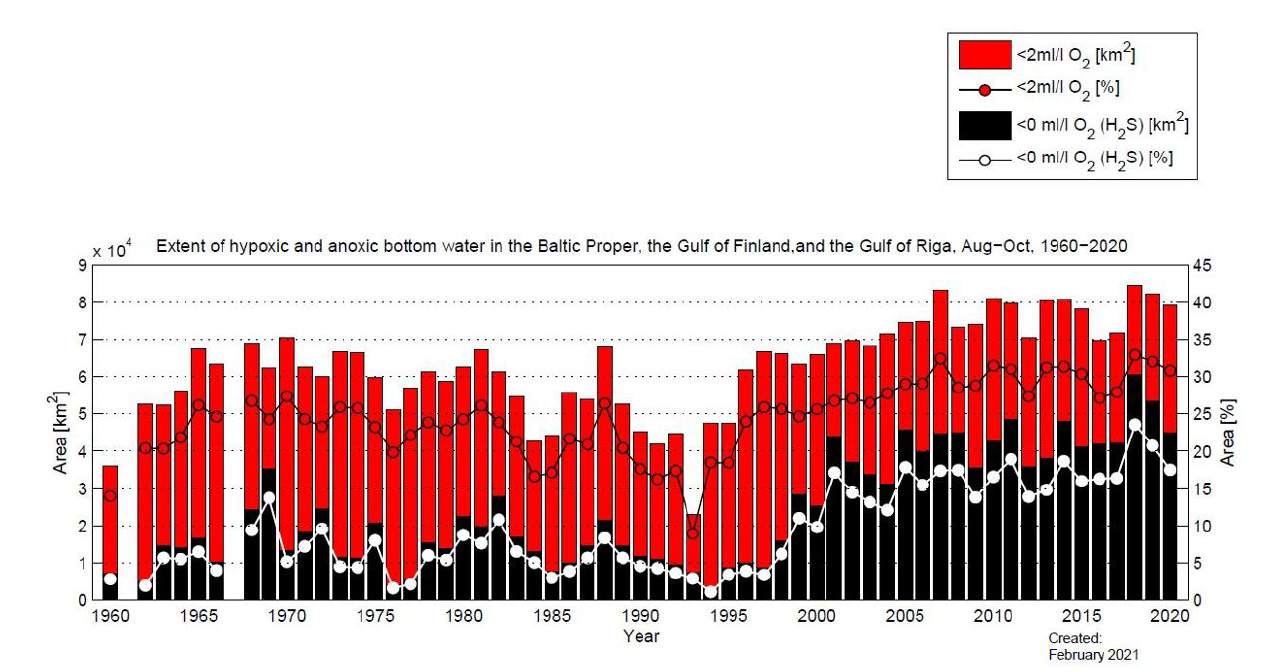
Figure 25. The extent of hypoxic ( < 2mLO 2 L − 1 ) and anoxic ( < 0mLO 2 L − 1 ) bottom water (in 10 4 km 2 ) in the Baltic proper, Gulf of Fin- land, and Gulf of Riga during regular cruises in August–October during 1960–2020. Source: https://www.smhi.se (last access: 5 March 2022) at the Swedish Meteorological and Hydrological Institute, Norrköping,